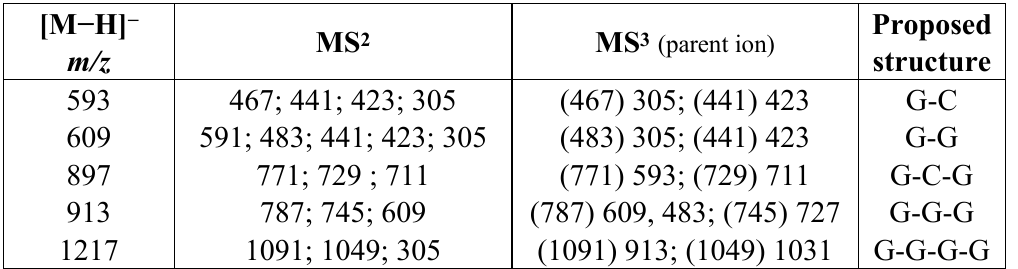
Table 2. Main [M − H] − ions observed in the DI-ESI spectrum and their collisionally generated fragments. Identification of compound structures was achieved on the basis of fragmentation pattern and comparison with literature data. Letters are indicating catechin unit (C), gallocatechin unit (G), upper units in the dimeric/polymeric derivatives are the first letter.